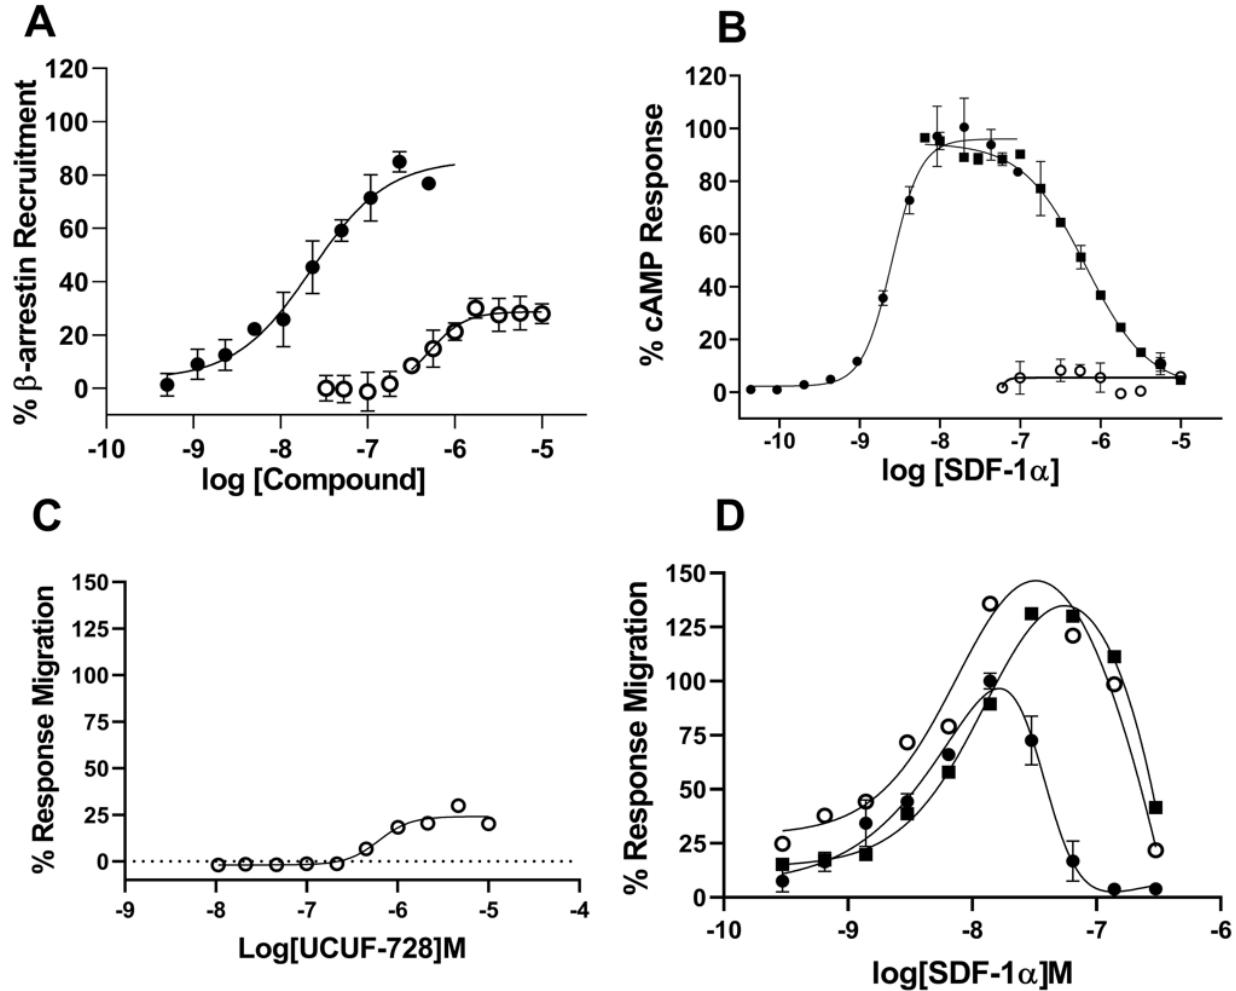
Figure 2. UCUF-728 is a positive modulator of b-arrestin signaling and cell migration. ( A ) UCUF-728 (open circles) is a dose-dependent partial activator of b-arrestin recruitment in CXCR4-bla U2OS cells compared to SDF-1a (closed circles). ( B ) SDF-1 α dose-dependently inhibits forskolin-induced cAMP signaling (closed circles) in CHO-K1-CXCR4 cells, and this maximal response at 40 nM SDF-1 α is inhibited by AMD3100 (closed squares). UCUF-728 (open circles) does not show dose-dependent activity in cAMP signaling. ( C ) UCUF-728 (open circles) is a dose-dependent partial activator of CEM-CCRF cell migration. ( D ) SDF-1a shows typical bell-shaped curve in CEM-CCRF cell migration (closed circles) and this response is modulated in the presence of 1 mM (closed squares) and 10 mM (open circles) UCUF- 728. Error bars are +/− SD of triplicate determinations. The CXCR4 receptor is a G -protein coupled receptor (GPCR) coupled to the Gi class, whose primary role is inhibition of adenylate cyclase. We tested the ability of UCUF-728 to induce a Gi-mediated cAMP-inhibitory cellular response. SDF- 1α inhibited forskolin - induced adenylate cyclase in CHO- K1 CXCR4 overexpressed cells and this response was dose-dependently blocked by AMD3100, a small bicyclam molecule that inhibits the binding of SDF- 1α to CXCR4 [13] (Figure 2B). However, UCUF-728 did not inhibit forskolin-induced adenylate cyclase in the overexpressed cell line, indicating biased signaling for β -arrestin recruitment over cAMP signaling (Figure 2A,B). SDF- 1α stimulates chemotaxis in a high percentage of resting and active T lymphocytes [14], and the CXCR4 receptor is highly expressed in the CEM (Leukemia)